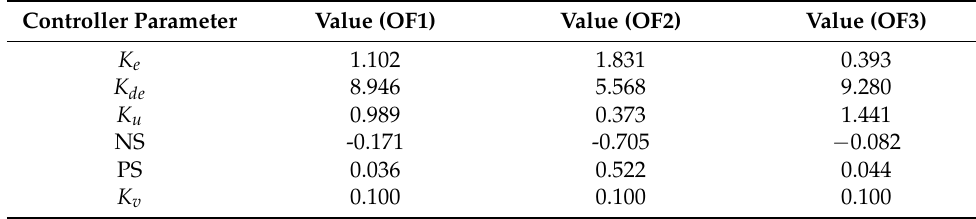
Table A3. Optimized velocity FLCS parameter